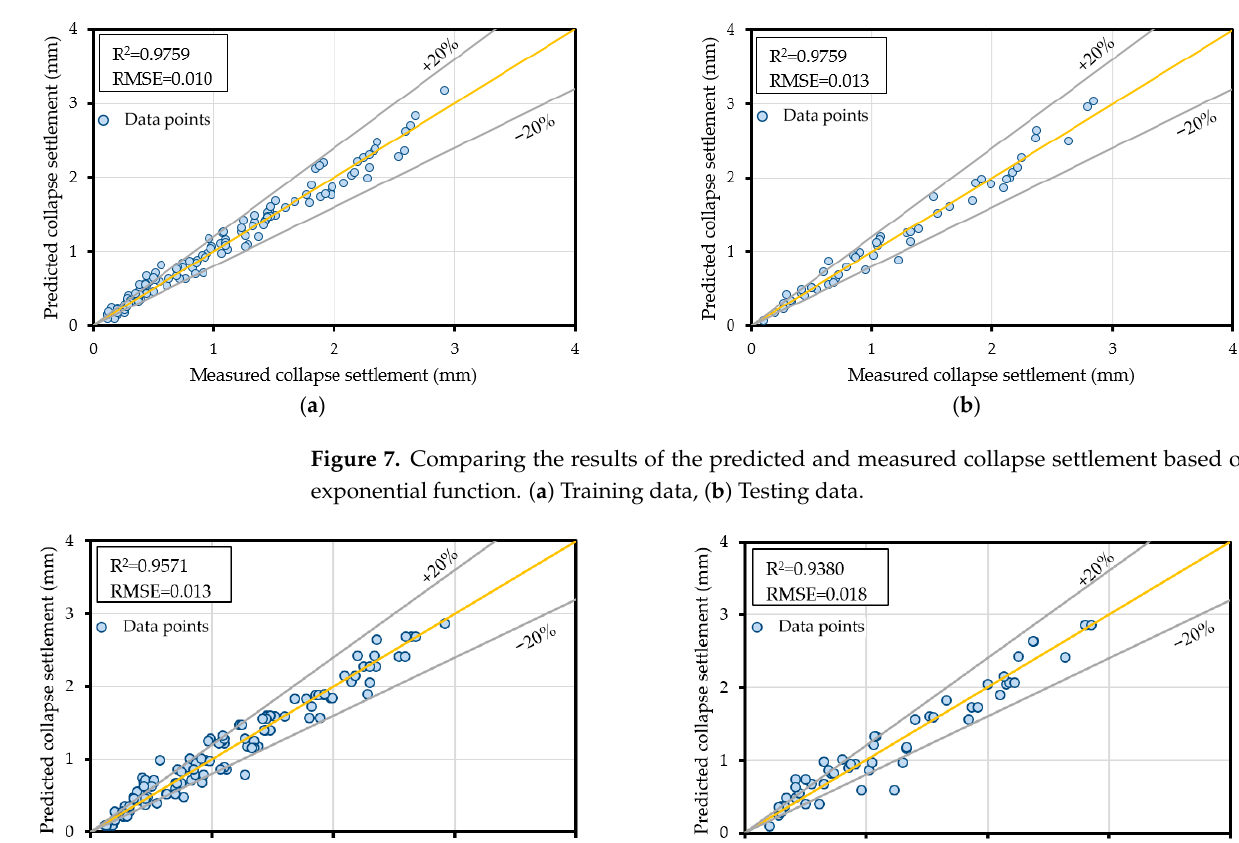
Figure 6. Comparing the results of the predicted and measured collapse settlement based on the natural logarithm. ( a ) Training data, ( b ) Testing data.